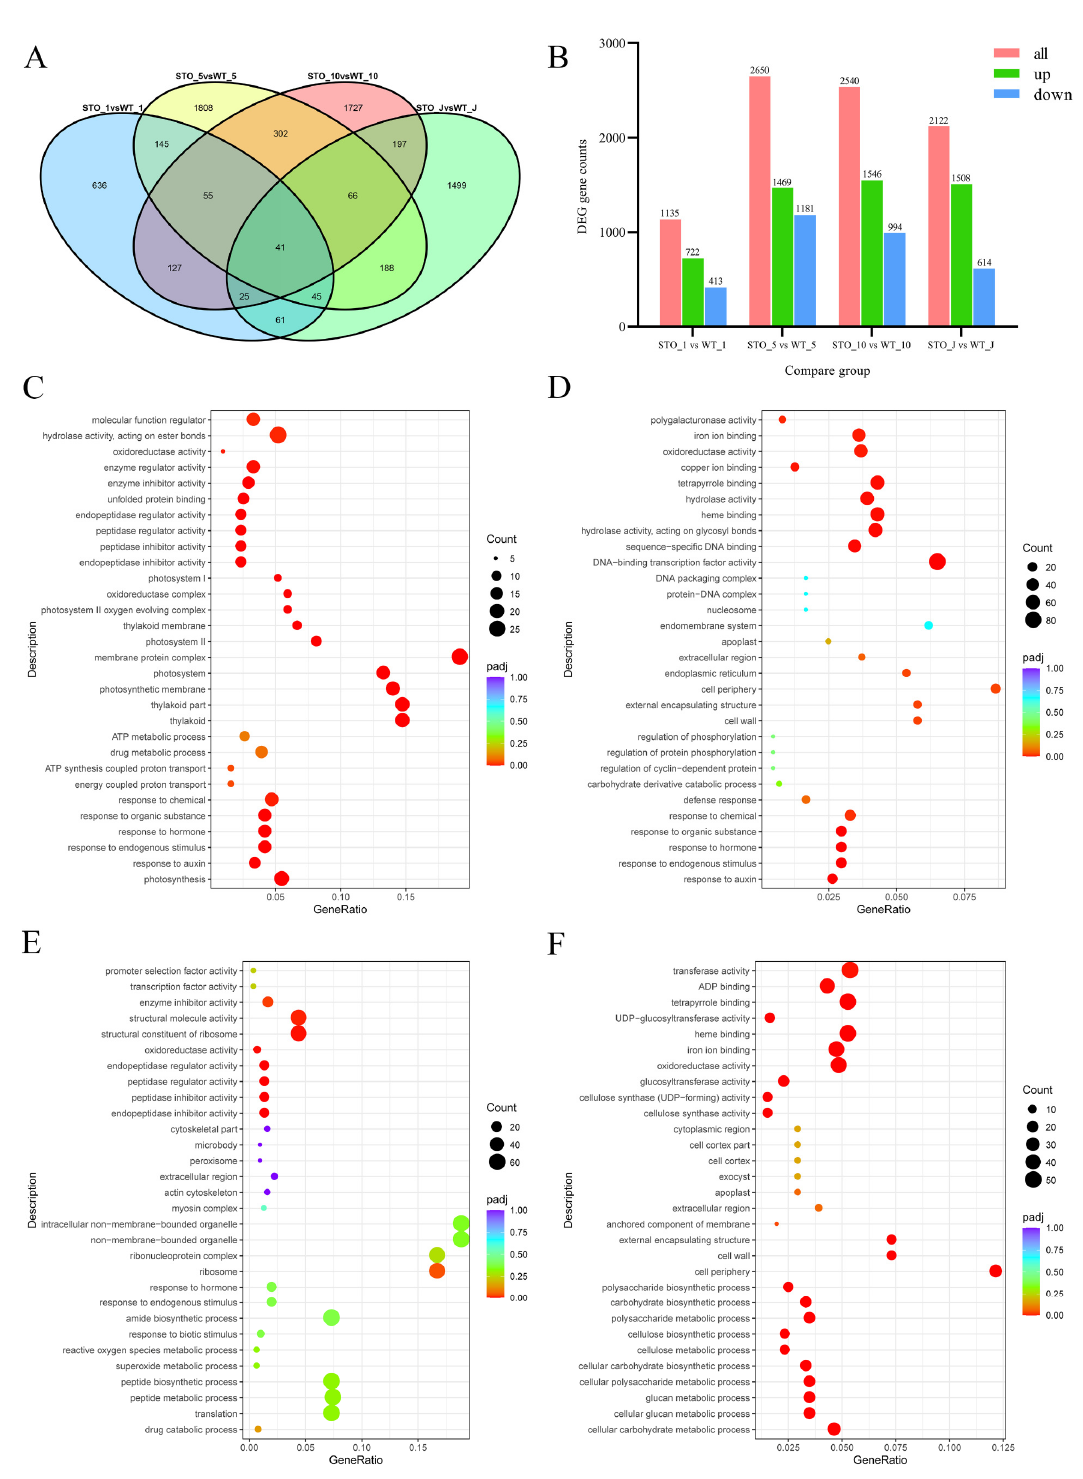
Figure 8. Identification of DEGs in PagSTOMAGEN -OE 84K poplar transgenic lines and GO enrich- ment analysis. ( A ) Venn plots for different sample combinations. ( B ) DEG gene counts for different sample combinations. Includes all up-regulated and down-regulated gene counts. GO enrichment analysis of 1st leaf position ( C ), 5th leaf position ( D ), 10th leaf position ( E ), and young stem ( F ) in STO-OE and WT lines. The Y-axis indicates the GO pathway; the X-axis indicates the gene ratio. The dot size indicates the number of DEGs in the pathway, and the dot color indicates the p